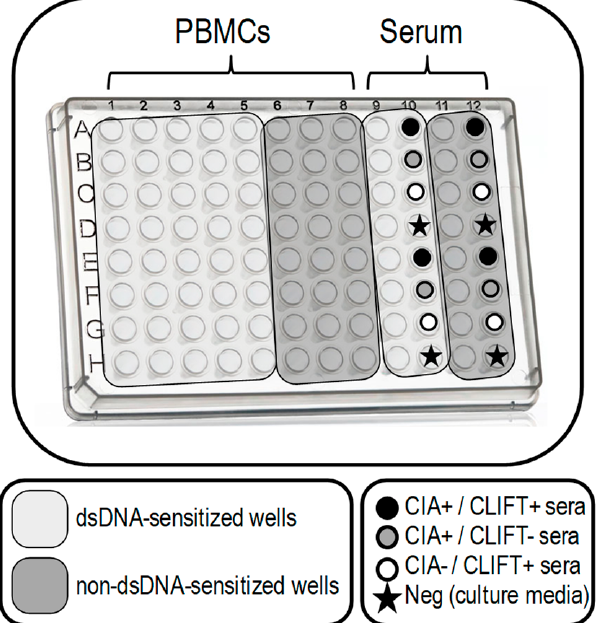
Figure 1. SLE-ELISpot plate design. SLE-ELISpot assay was performed with PBMCs (columns 1 to 8). Sera samples (columns 9 to 12) were included as a control for the technical procedure (being columns 9 and 11 for patients sera and columns 8 and 10 for selected controls with a known result for CIA and CLIFT). Wells in light grey are dsDNA-sensitised. Dark grey wells are non-dsDNA-sensitised. Each row was used for one patient.